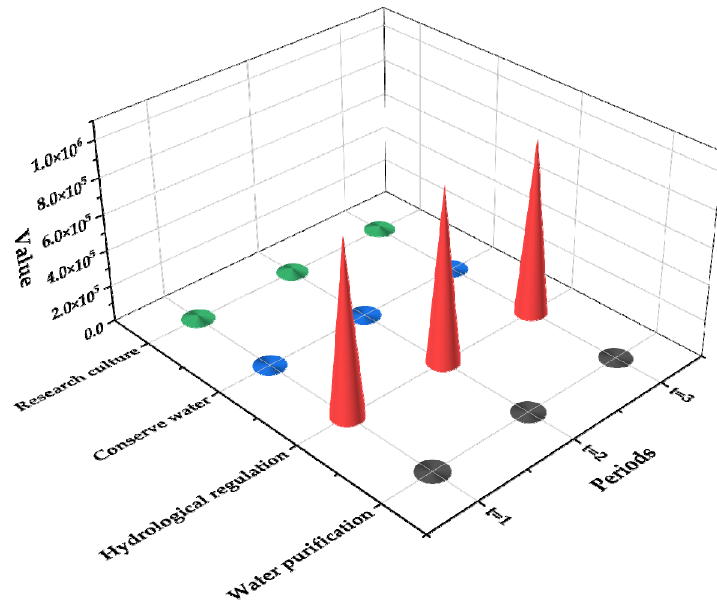
Figure 9. Ecological regulation service value (10 4 CNY/year).